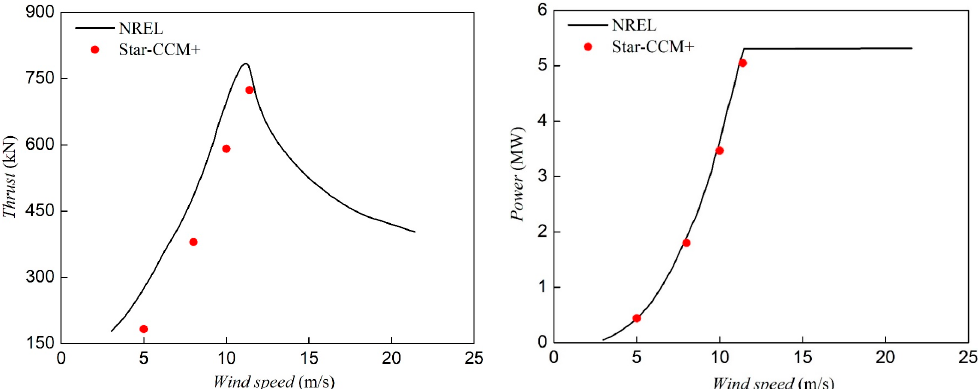
Figure 6. Comparisons of thrust and power.